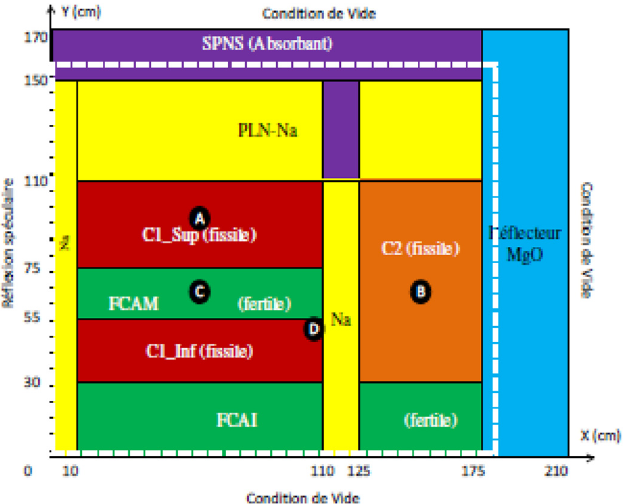
Fig. 1. The XY toy model used for validation. Color code: yellow =sodium (plenum or rod followers), red=inner fuel, orange= outer fuel, green= fertile (lower axial blanket, plate in the inner core), purple =absorbers, blue= re fl ector. Boundary conditions: specular re fl ection (left), vacuum (right, top and bottom). The dashed white line encloses the regions represented in Figure 2 and Figures 4 to 8.